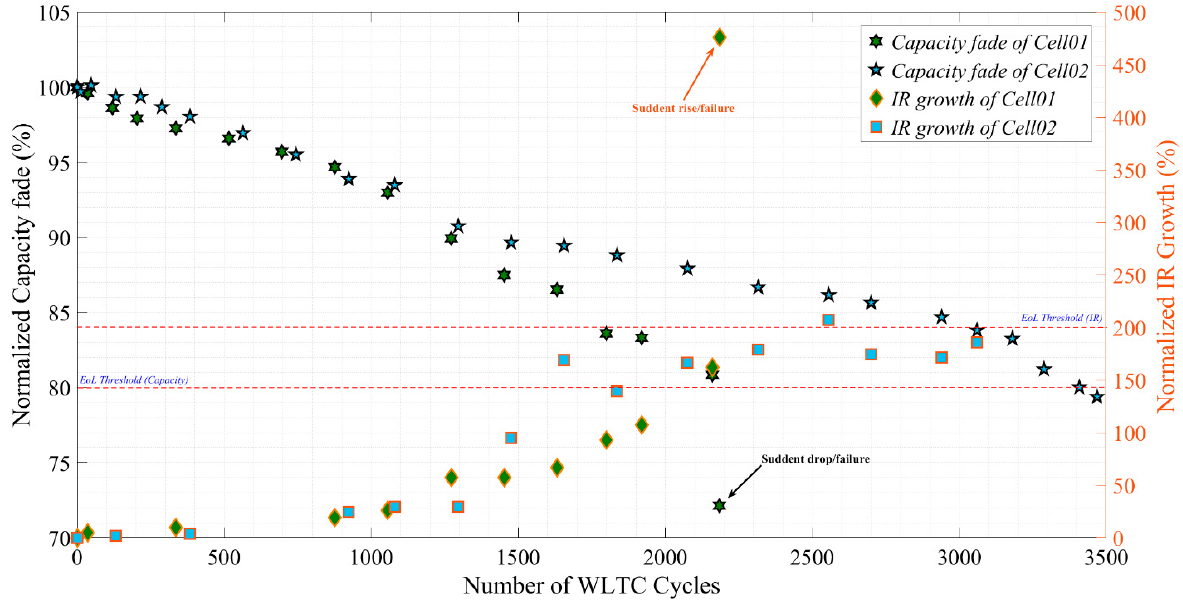
Figure 2. WLTC degradation results with WLTC current profile at 45 ◦